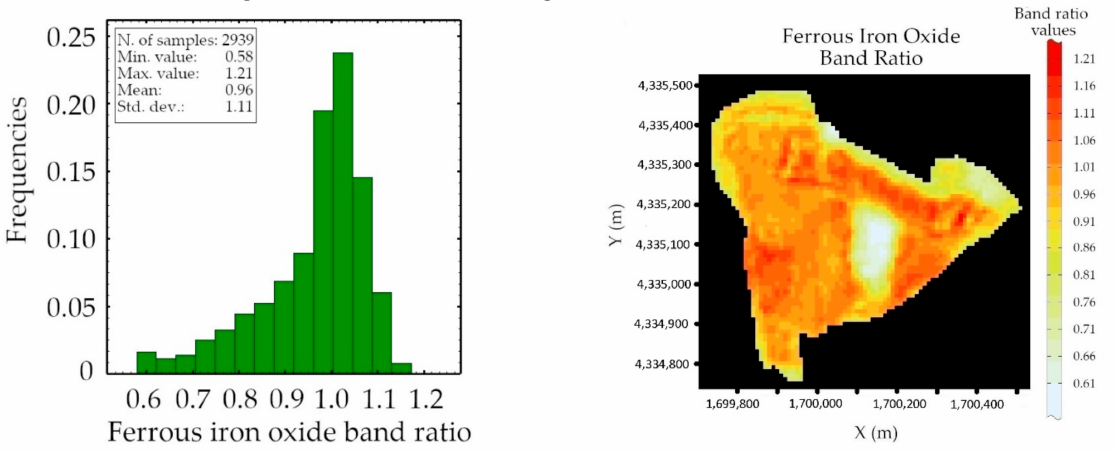
Figure 4. Histogram of ferrous iron oxides band ratio ( left ) and its base map ( right ).